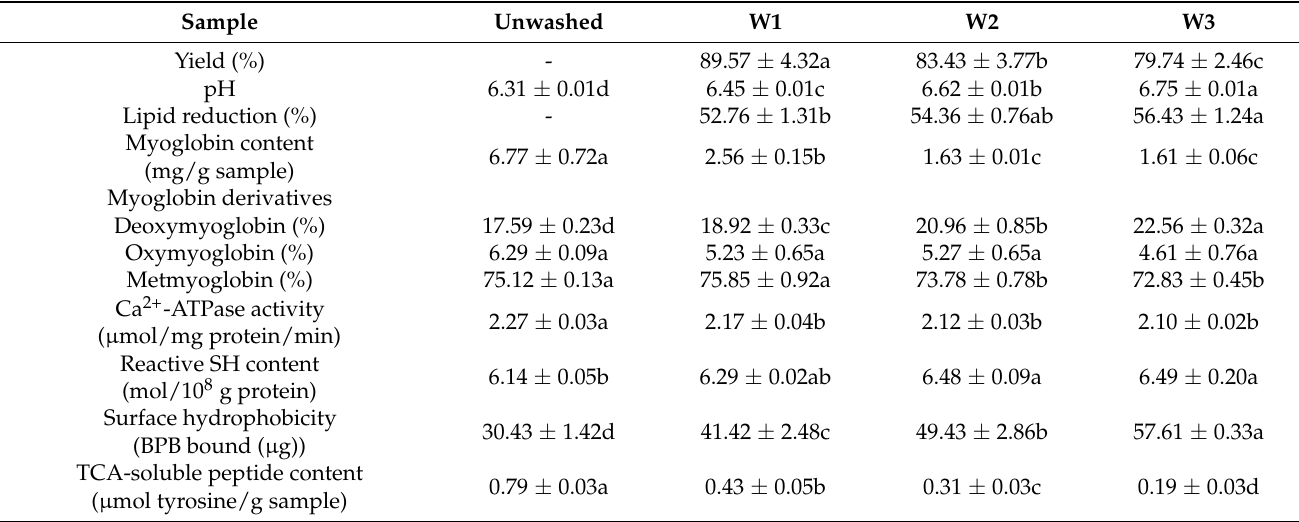
Table 1. Yield and bio-physico-chemical properties of Indian mackerel unwashed mince and surimi prepared by different washing